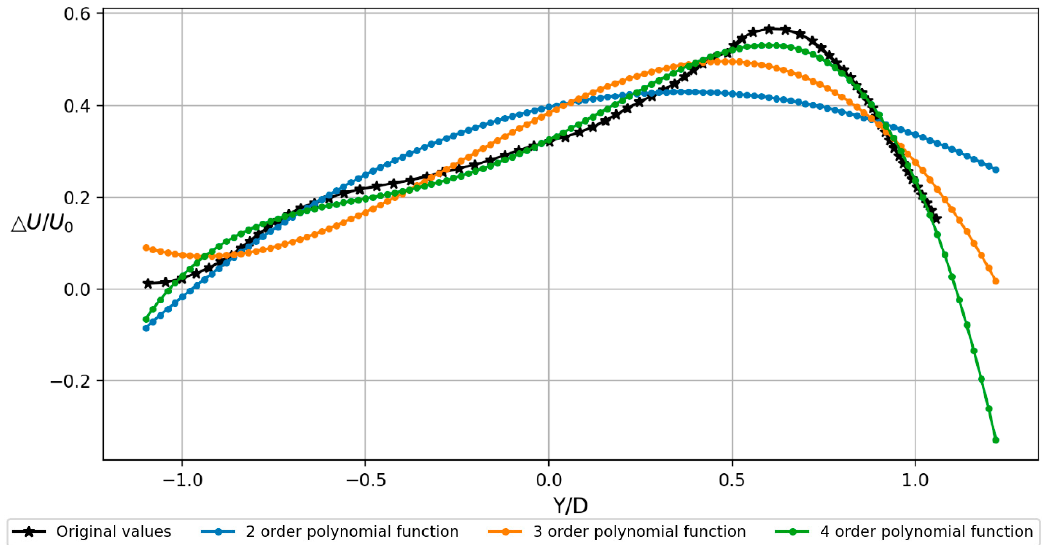
Figure 2. The comparison between the original data and three polynomial functions. The original data is the velocity profile at 3D position in a PIV experiment [8]. X-axis is the position of cross-section which is normalized by the diameter D . Y-axis is the velocity deficit which is normalized by the inlet velocity U 0 . (2 order polynomial function: − 0.2366 x 2 + 0.1769 x + 0.3962. 3 order polynomial function: − 0.3023 x 3 − 0.2081 x 2 + 0.4036 x + 0.3834. 4 order polynomial function: − 0.4382 x 4 − 0.2933 x 3 + 0.246 x 2 + 0.397 x + 0.3248. The polynomials are calculated by the fitting program of Python).